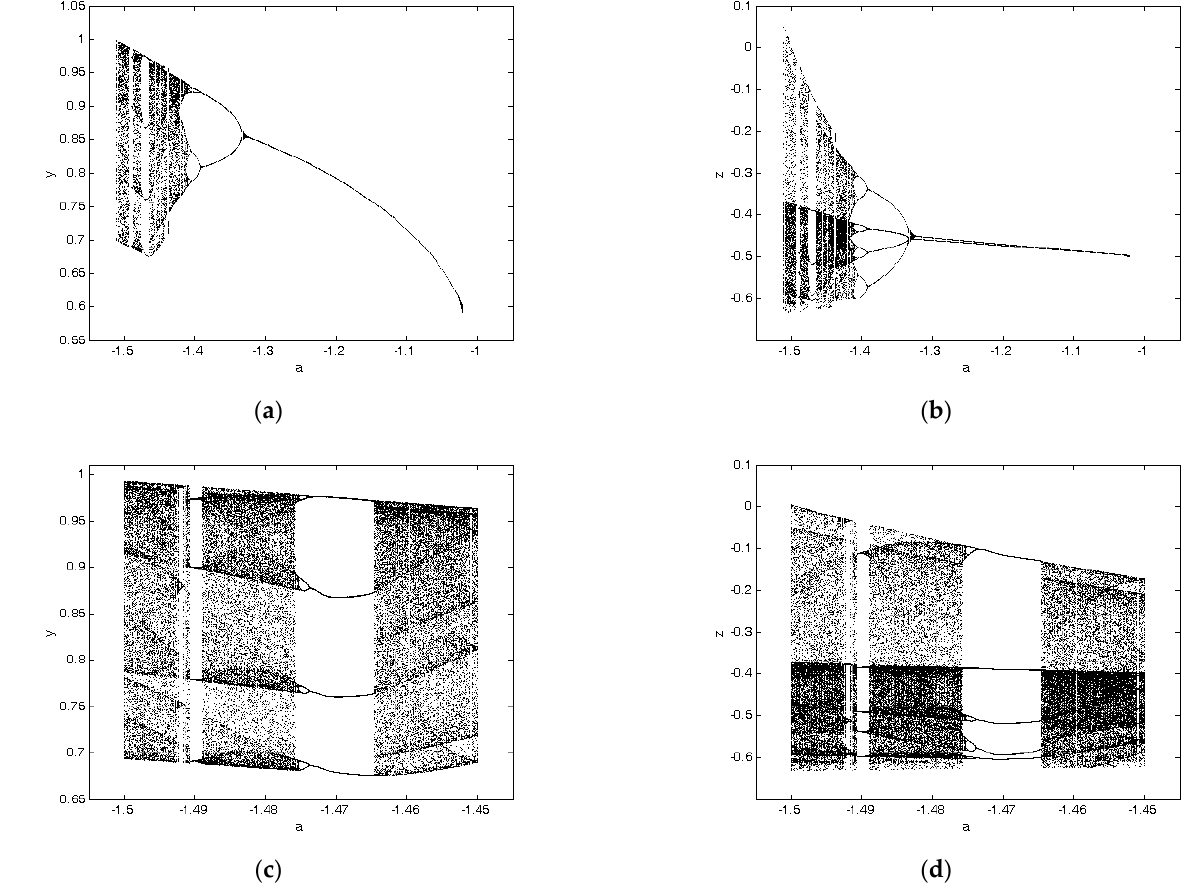
Figure 6. Bifurcation diagram of system (1) at fixed point note that R = 0 is boundary for Andronov-Hopf bifurcation